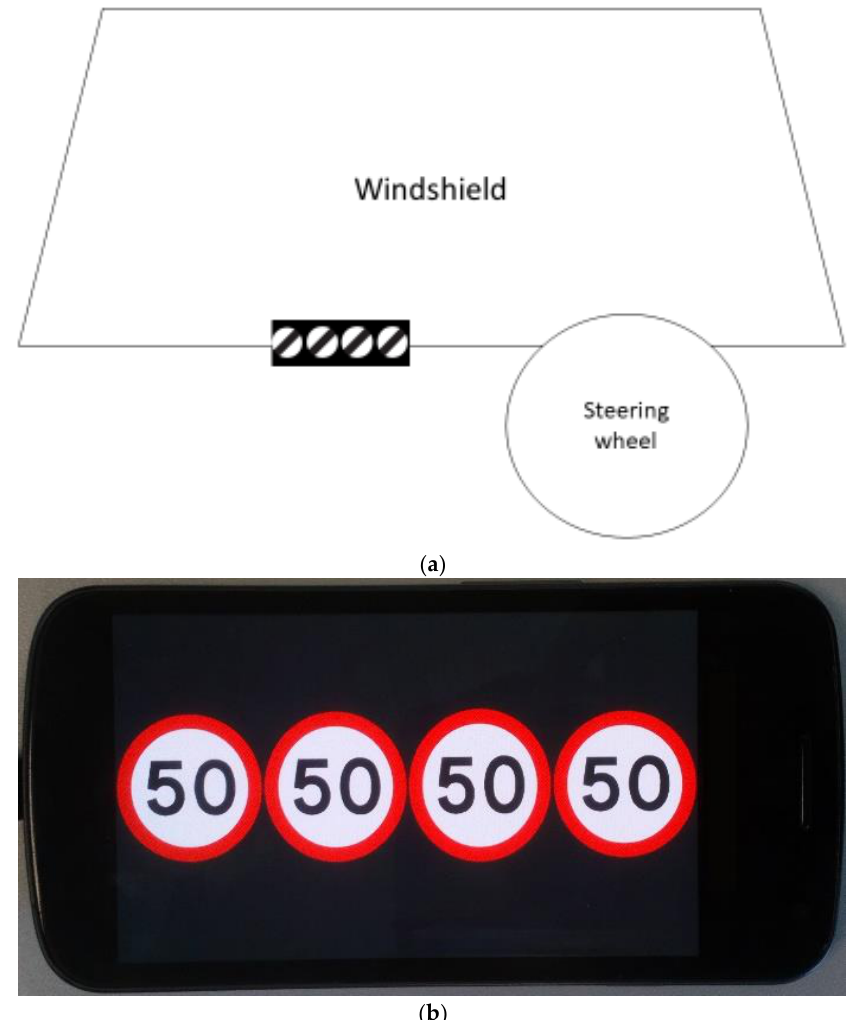
Figure 4 . ( a ) Sketch of the HMI location with the national speed limit signs (i.e., 70 mph). ( b ) Illustration of the 50pmh VSL displayed on the mobile phone .